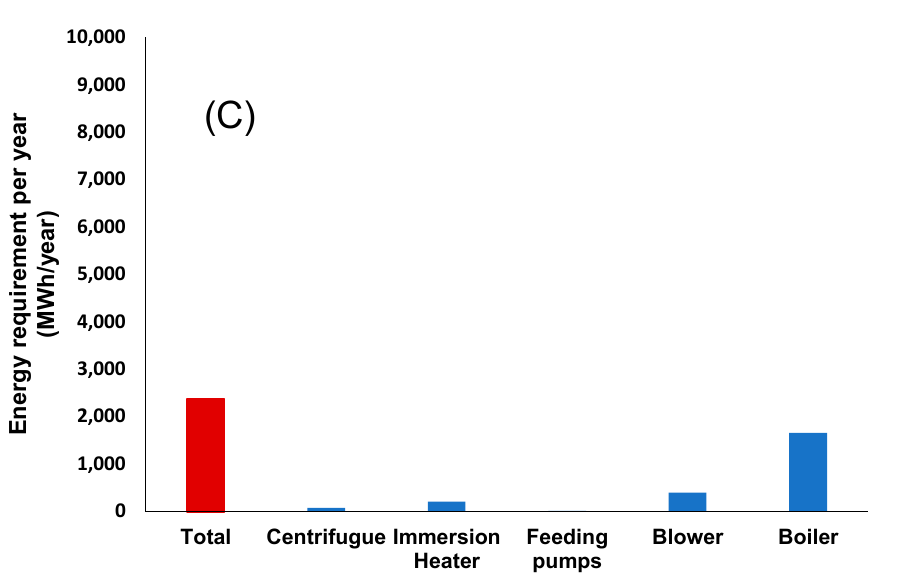
Figure 5. Annual energy requirements for: ( A ) thermal pre-treatment; ( B ) micro-aerobic pre-treatment of waste-activated sludge without thickening; ( C ) micro-aerobic pre-treatment of thickened waste-activated sludge.